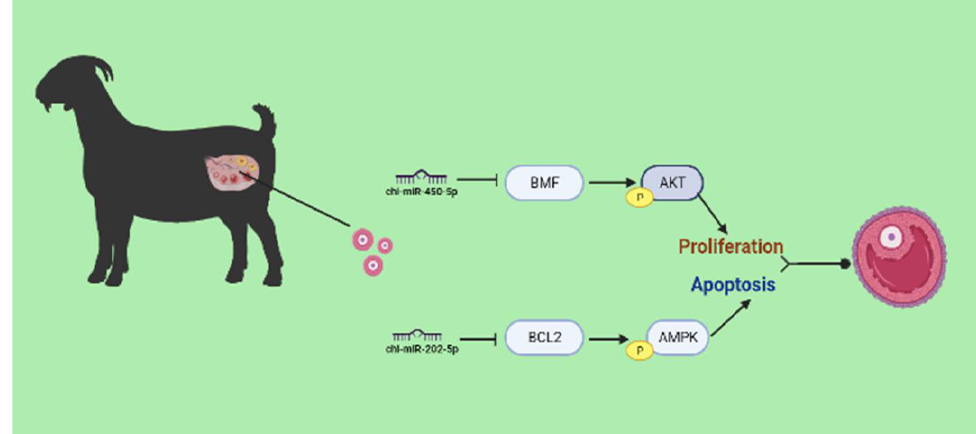
Figure 8. Diagram of miR-450-5p and miR-202-5p regulatory follicle development pathway.